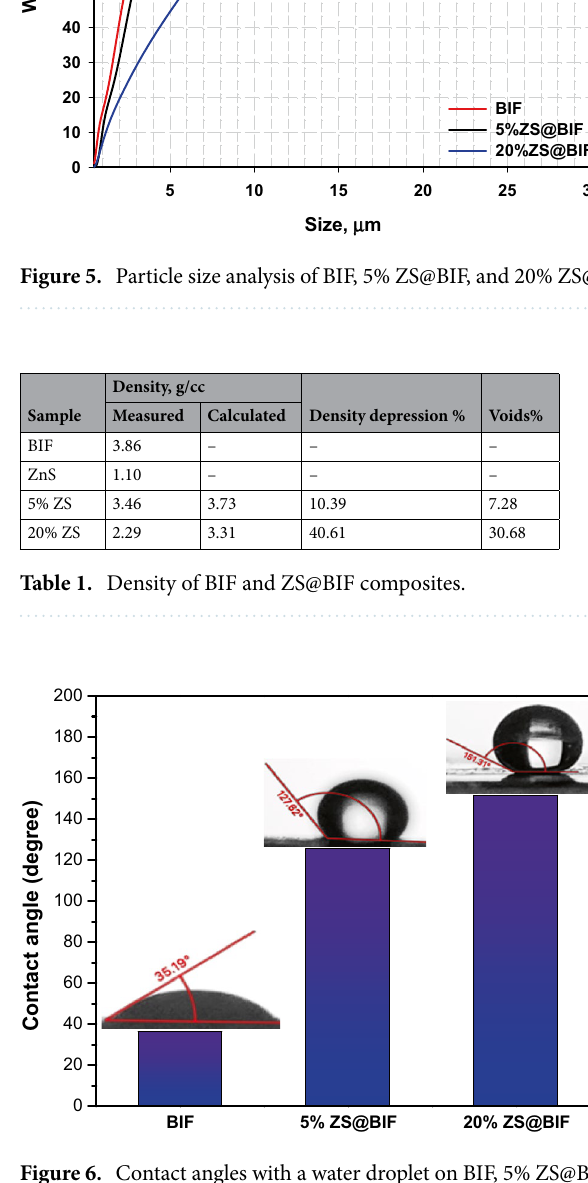
Figure 6. Contact angles with a water droplet on BIF, 5% ZS@BIF, and 20%